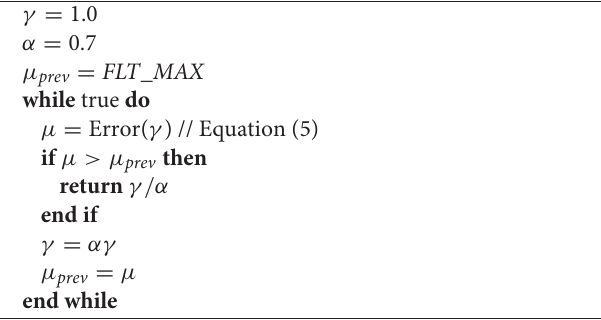
FIGURE 4 | (Left) Smoke-like artifacts is a way for the algorithm to compensate for view-dependent surfaces. (Right) Result with a threshold on the accumulated opacity during rendering.